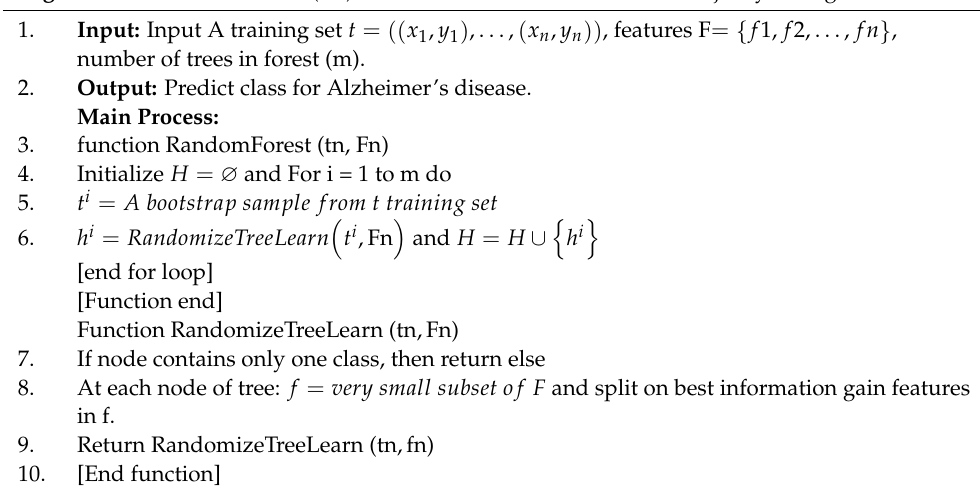
Algorithm 2: Random Forest (RF) classifier and final decision with majority voting